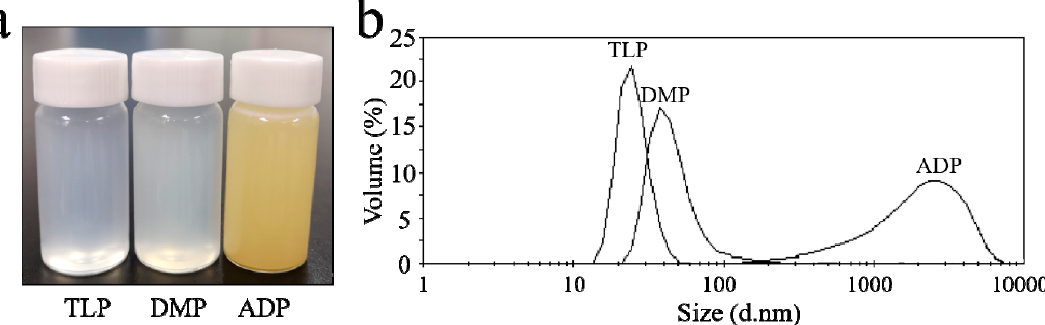
Figure 1. ( a ) Photograph of TLP, DMP, and ADP dispersed emulsions at a concentration of 3 g/L (72 h); ( b ) Droplet size distribution of TLP, DMP, and ADP dispersed emulsions.